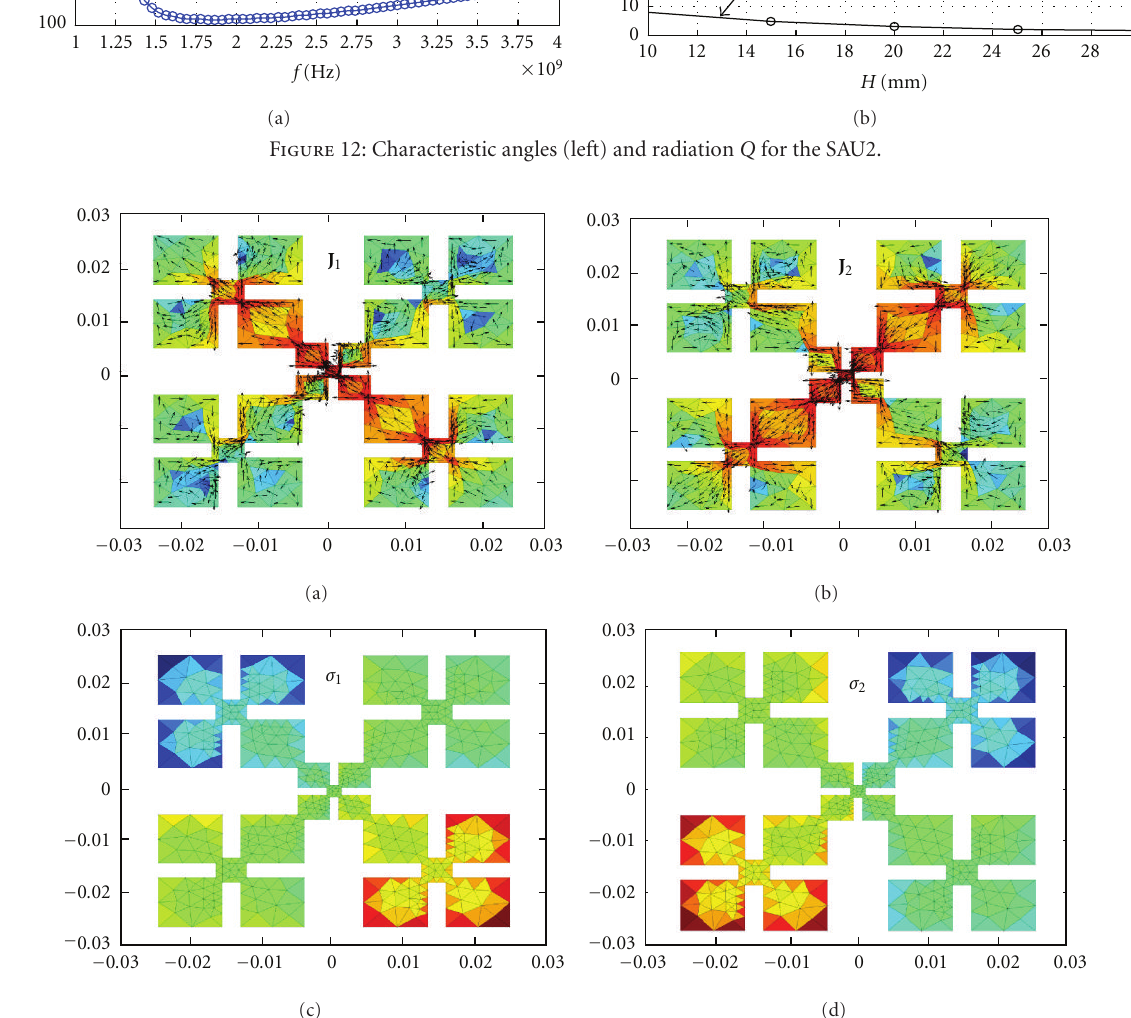
Figure 13: Degenerated dominant mode J 1 , and J 2 of the FCL2 antenna (currents and